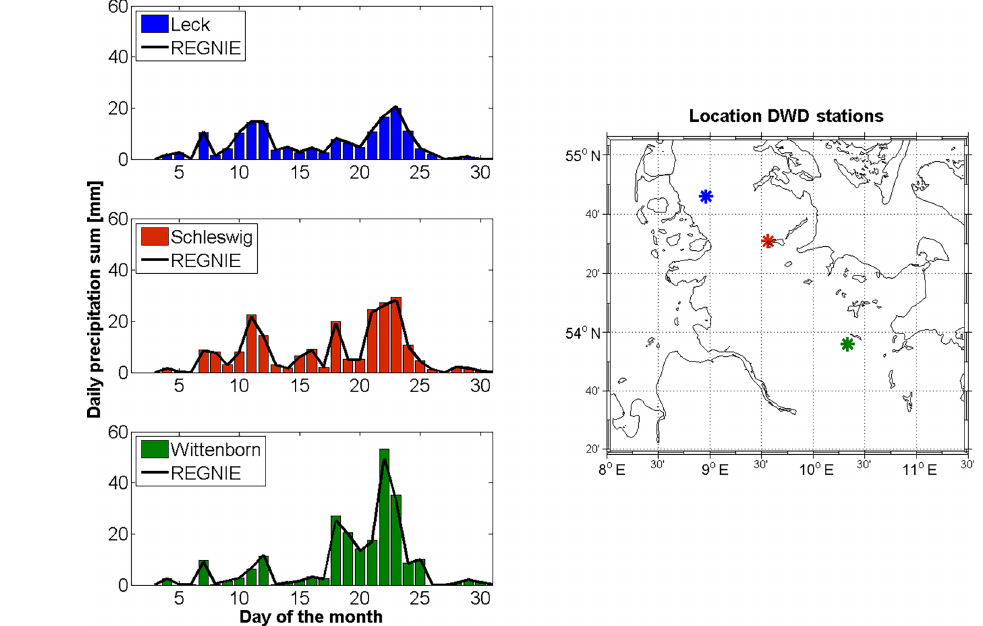
Figure 5. Daily precipitation sums at DWD stations in northern (Leck), central (Schleswig), and southern (Wittenborn) Schleswig-Holstein, December 2014. Black lines indicate REGNIE daily precipitation sums at the closest respective grid points.